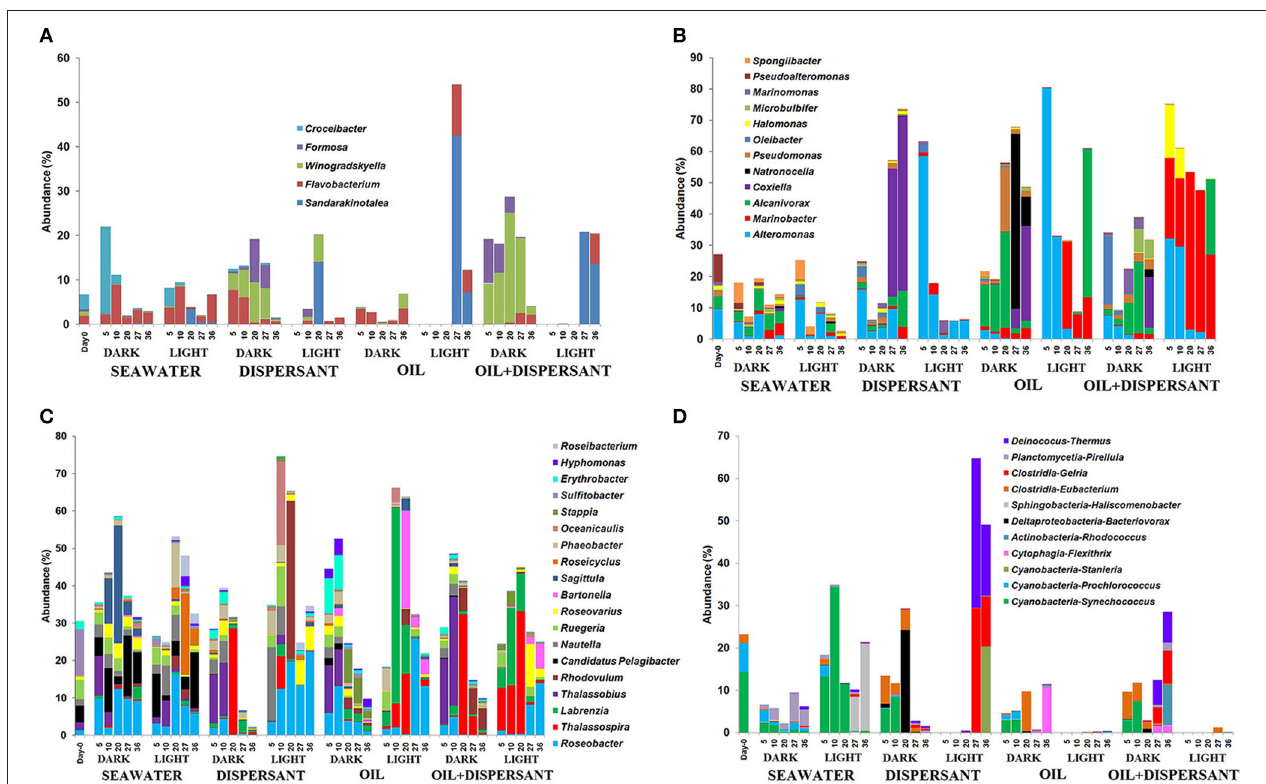
FIGURE 6 | Abundances of bacteria at genus level in seawater alone, seawater with dispersant Corexit, crude oil, and both oil and dispersant incubated under the dark and light conditions for 36 days. Only abundances greater than 5% in at least one of the samples are shown. (A) Flavobacteria , (B) Gammaproteobacteria, (C) Alphaproteobacteria , (D) Other bacteria. The numbers indicate days of